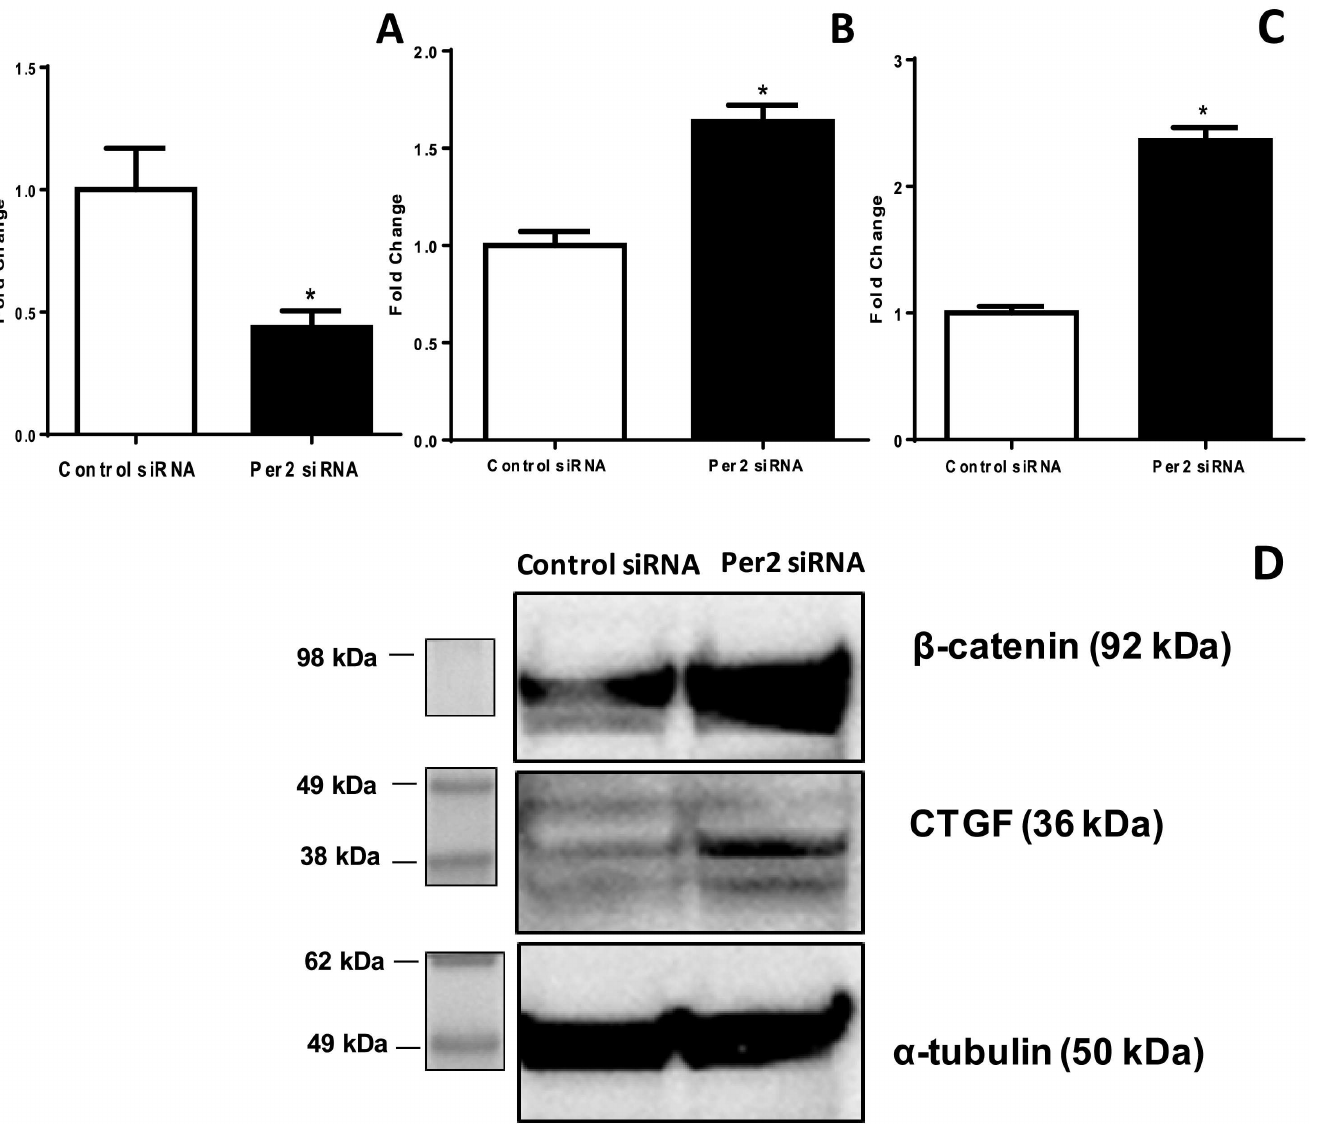
Fig 4. Per2 -silencing in HRECs results in an increase in β -catenin and CTGF. HRECs were treated with either scrambledcontrol siRNA or Per2 siRNA; bar graphs show mRNA expression of (A) Per2 , (B) β -catenin and (C) CTGF, n = 4. (D) Western blots show a similar changein the protein expressionof β -cateninand CTGF followinga treatment with siRNA Per2 . n = 3, * p <